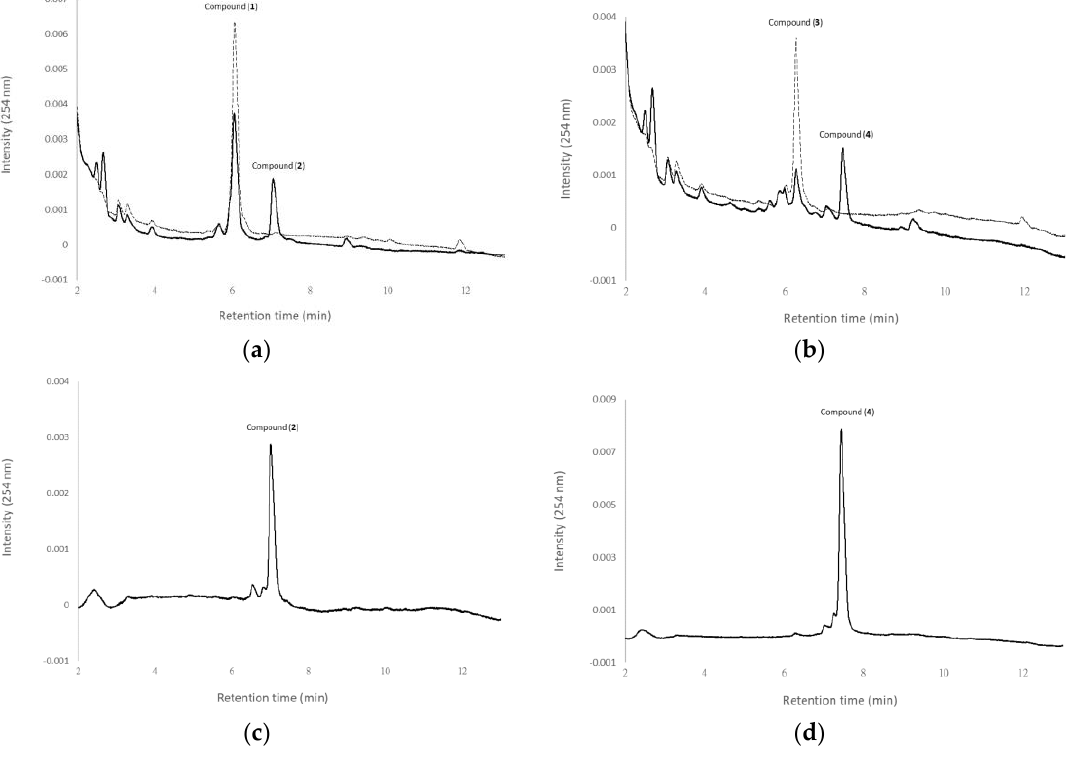
Figure 3. Biotransformation of compound ( 1 ) and compound ( 3 ) by B. subtilis ATCC 6633. The strain was cultivated in MGN media containing compound ( 1 ) ( a ) and compound ( 3 ) ( b ). The initial (dash curves) and 24 h (solid curves) cultivations of the fermentation broths were analyzed with a UPLC system equipped with a Kinetex ® UPLC C18 column (1.7 µm, 2.1 i.d. × 100 mm, Phenomenex Inc., Torrance, CA, USA). Purified compound ( 2 ) ( c ) and compound ( 4 ) ( d ) were used as standards. The UPLC operation conditions are described in Materials and Methods.